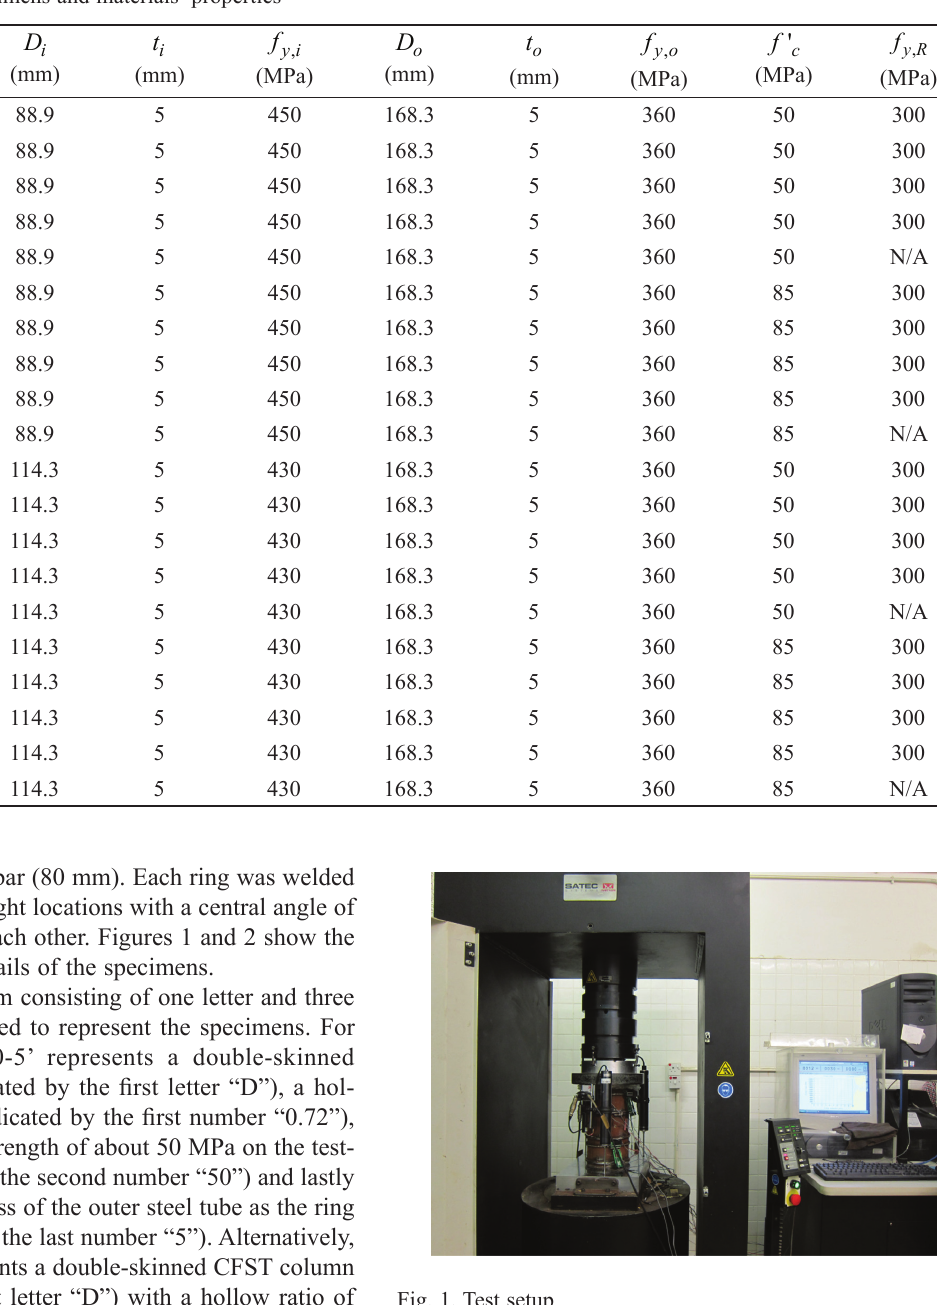
specimensFig. 1. Test